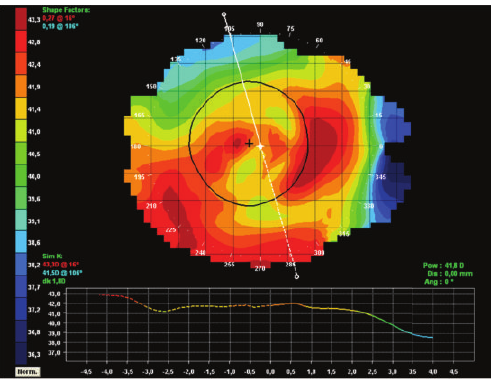
Figure 6: RE topography showing an improvement in the asymme- try 1 year after removal of